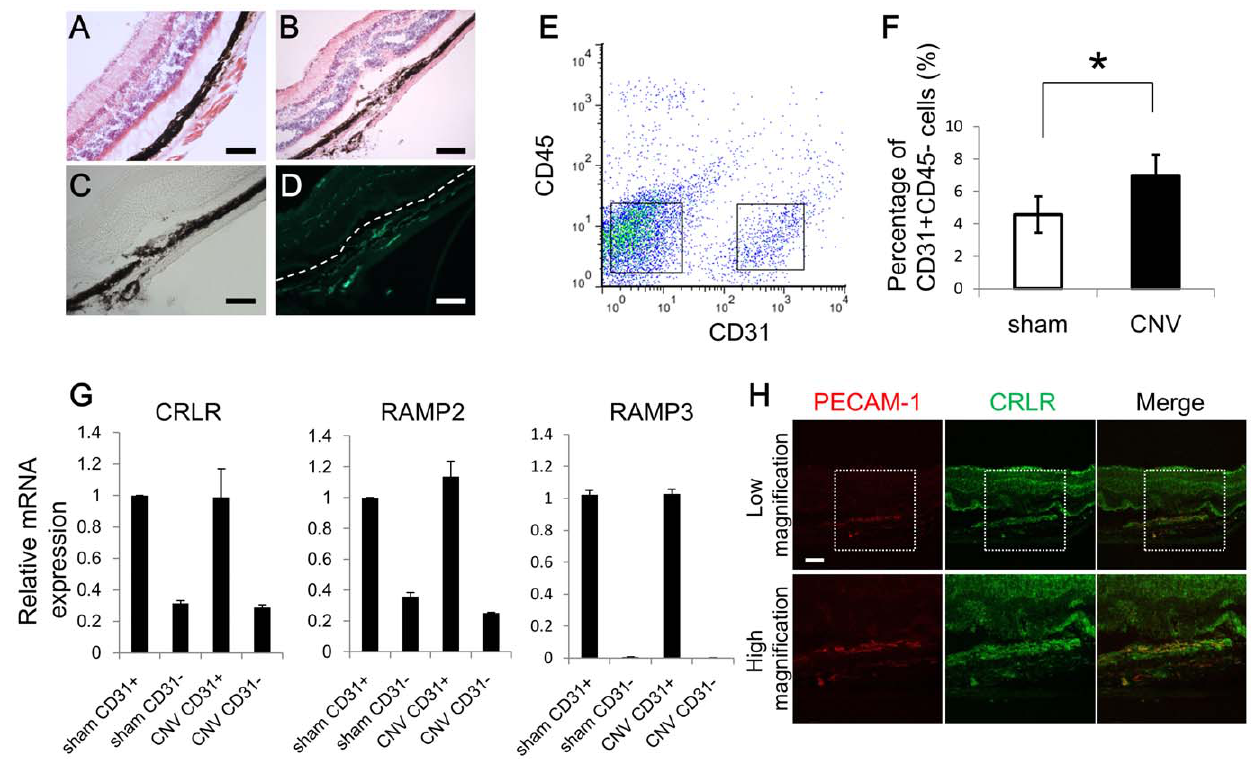
Figure 1. Expression of ADM receptors in choroidal ECs. (A, B) Hematoxylin-eosin-stained light micrograph of normal eye (A) and CNV lesion 7 days after laser treatment (B). Bar, 100 m m. (C) Light micrograph of serial sections of (B). Bar, 100 m m. (D) Immunohistochemistry of (C) with anti- PECAM-1/CD31 antibody. Dotted line indicates the borderline between the neural retina and RPE. Because the CNV lesion did not invade into the retina in this model, we could sort the ECs not from nerural retina but from CNV lesions and choroidal tissue in the following flow cytometry experiments. Bar, 100 m m. (E) Flow cytometric analysis of choroidal ECs from wild-type mice. CD31 + CD45 2 cells gated on the right are designated as ECs. (F) Quantitative evaluation of the percentage of choroidal EC 7 days after laser treatment. The number was calculated per cell total (n= § 5, *P , 0.05). (G) qRT–PCR analysis of ADM receptor component expression in choroidal ECs. The value in CD31 + CD45 2 ECs was compared with that in CD31 2 CD45 2 non-ECs sorted as gated in (A). Note that the expression level of ADM receptors is not significantly different between ECs and non-ECs in both sham-operated mice (sham) and laser-irradiated CNV mice (CNV). (H) Immunostaining of the CNV 7 days after laser treatment with anti- PECAM-1 (red) and anti-CRLR (green) antibody. High maginification indicate the dotted box in Low magnification. Bar, 100 m